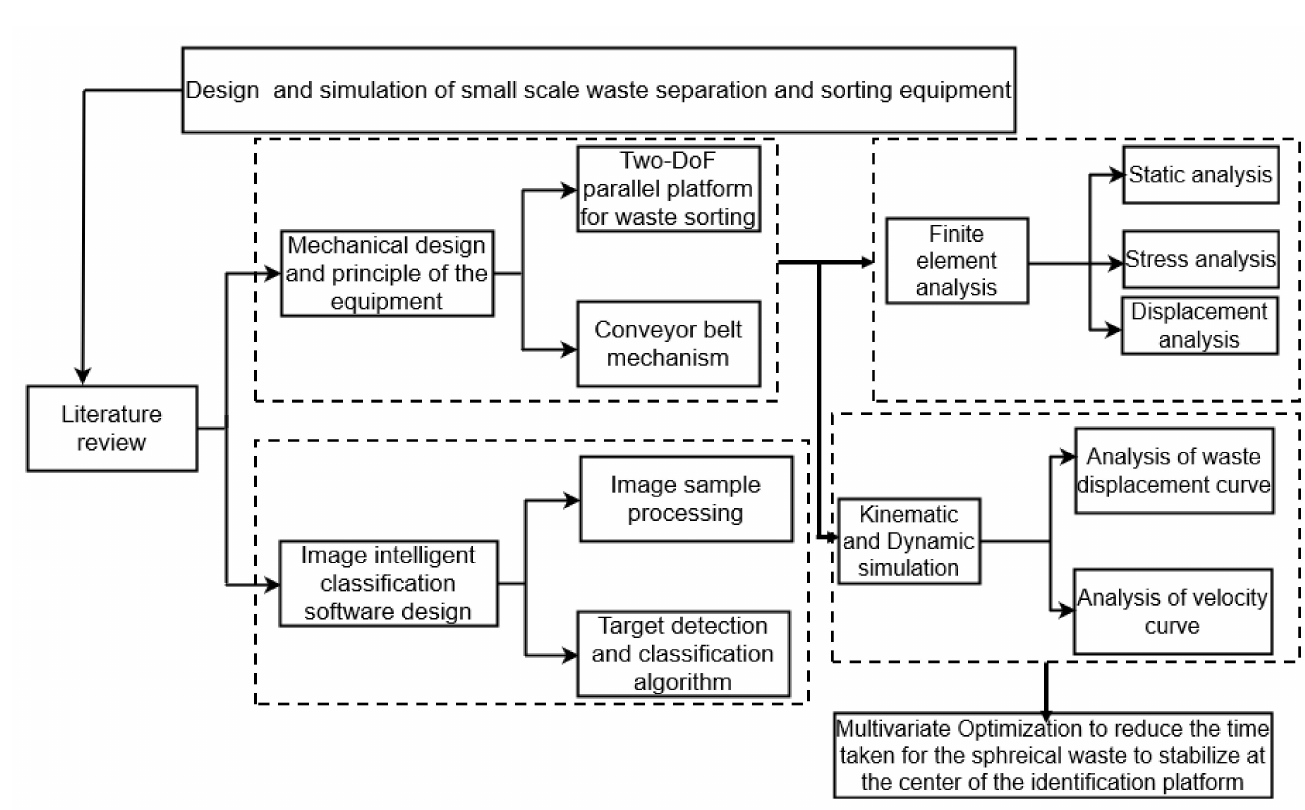
Figure 1. Schematic illustration of the study design. The schematic diagram shows the mechanical